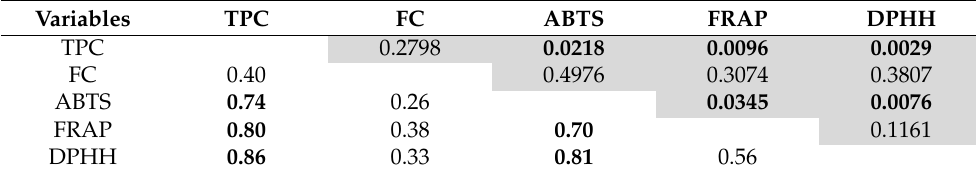
Table 2. Correlation matrix between the phenolic content (TPC), flavonoid content (FC), radical scav- enging test (ABTS), ferric reducing antioxidant power (FRAP), and free radical scavenging (DPPH). Variables TPC FC ABTS